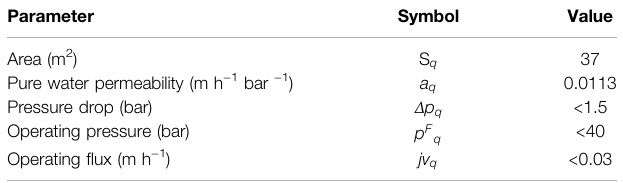
TABLE 5 | NF-90 module properties.